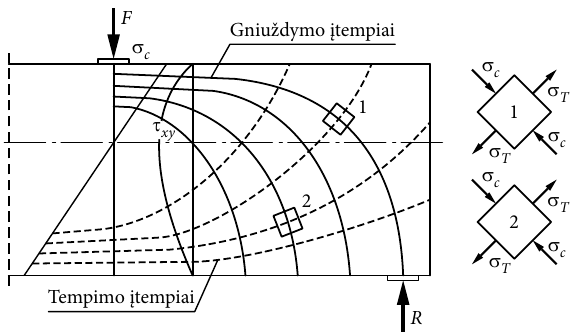
Fig. 1. Stress distribution in the most dangerous zone, according to formation of shear